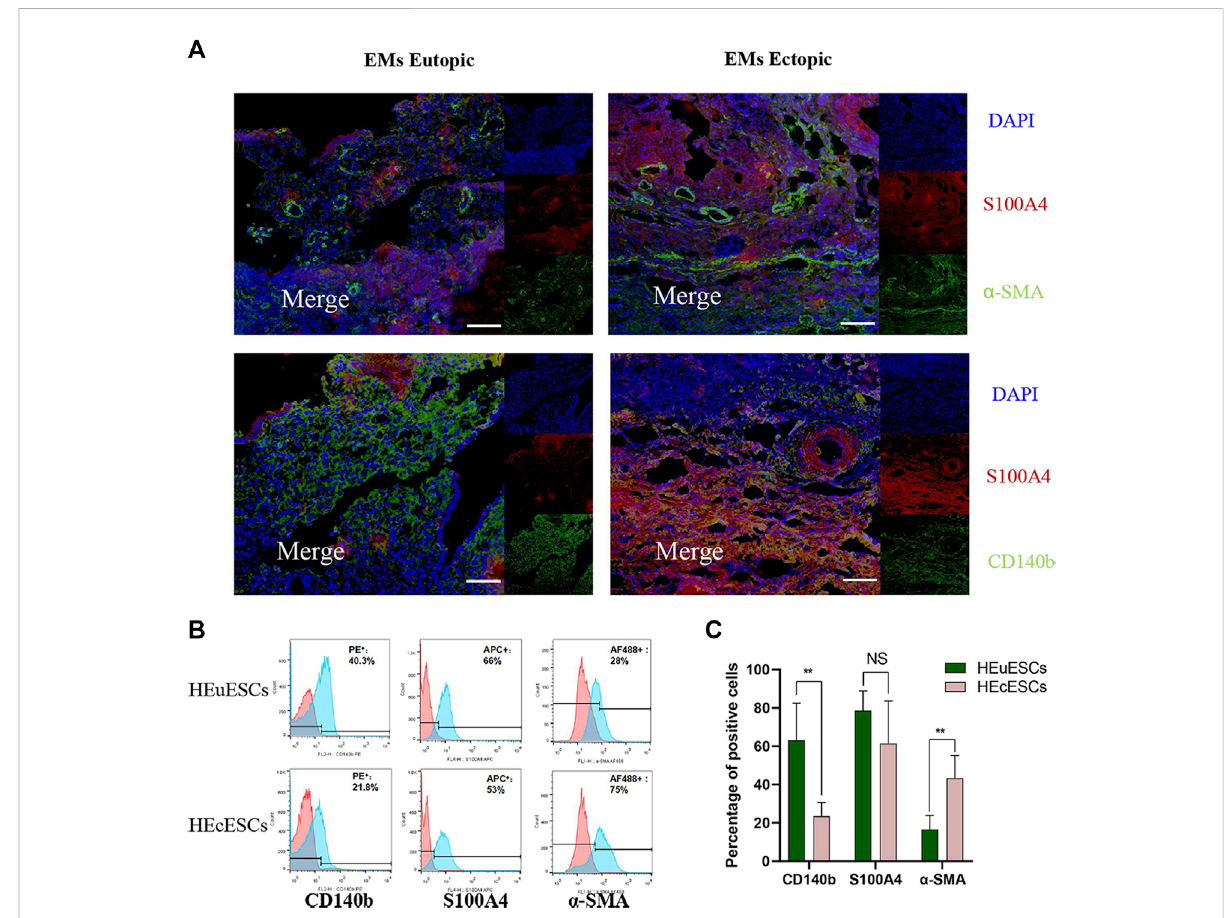
Heterogeneity of stromal cells in eutopic and ectopic tissues. (A) Sections of eutopic and ectopic tissues were stained with antibodies against stromal cell markers. CD140b for mesenchymal stromal cells (green), S100A4 for fi broblasts (red), and a-SMA for myo fi broblasts (green). There are differentkindsofstromalcellswithdifferentproportionsinectopicandeutopictissuesofEMs. (B – C) RepresentativeFACSanalyses (B) andstatistical results (C) of HEuESCs and HEcESCs at early culture passages. The proportion of the CD140b or a-SMA positive cell types in HEuESCs and HEcESCs does differ signi fi cantly. Scale bars: 50 μ m, Summary data are presented as the mean ± SEM. Signi fi cance in (C) was calculated using a Student t-test; * p < 0.05, ** p < 0.01, *** p <